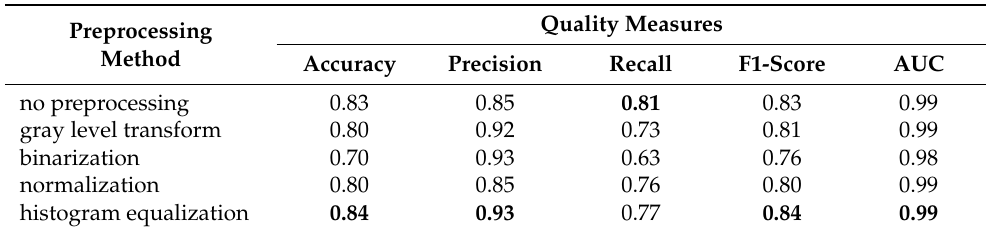
Table 2. Classification quality measures on the validation set for the VGG13 model with various preprocessing methods applied to the input images. Best values are highlighted in bold. Quality measures and image preprocessing methods are described in